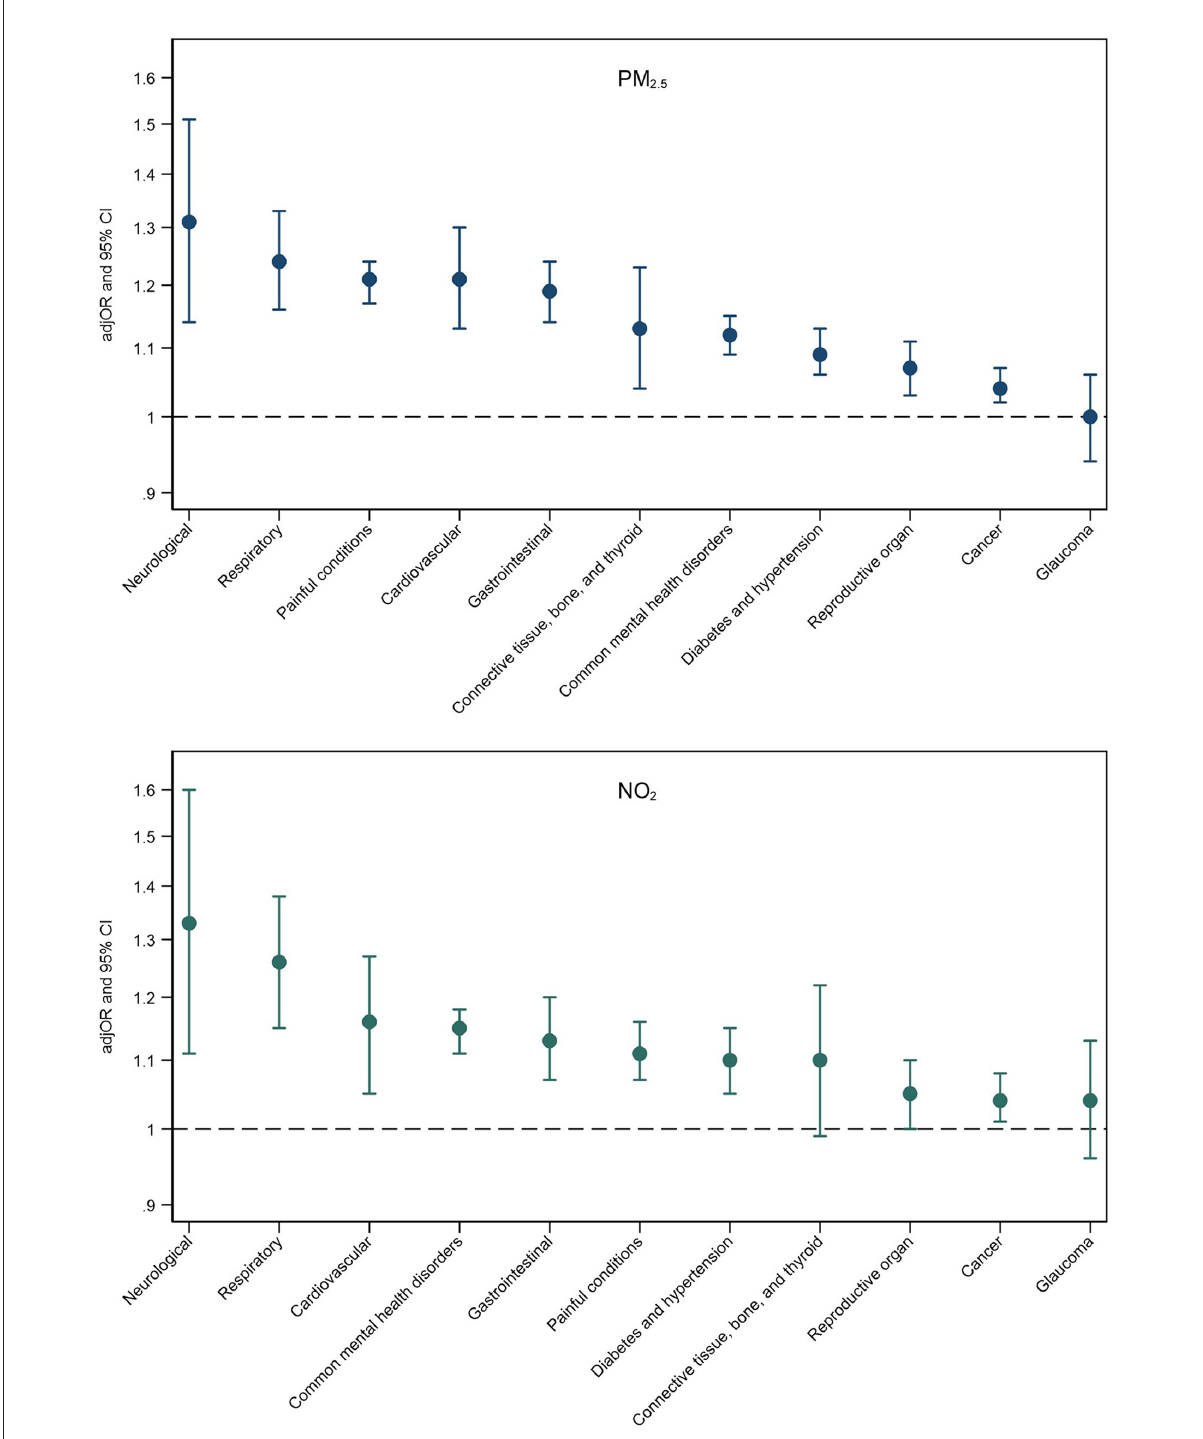
FIGURE2 Adjusted odds ratios (adjOR) and their corresponding 95% confidence intervals (CI) from logistic regressions examining associations between PM 2.5 (top) and NO 2 (bottom) exposure and the likelihood of belonging to a specific multimorbidity (reference group: those without multimorbidity). All models are adjusted for age, sex, ethnicity, education level, employment status, household income, smoking status, alcohol intake frequency, BMI, physical activity, nearest major road, traffic intensity on nearest major road, residential green space (1,000m) and 24h noise pollution